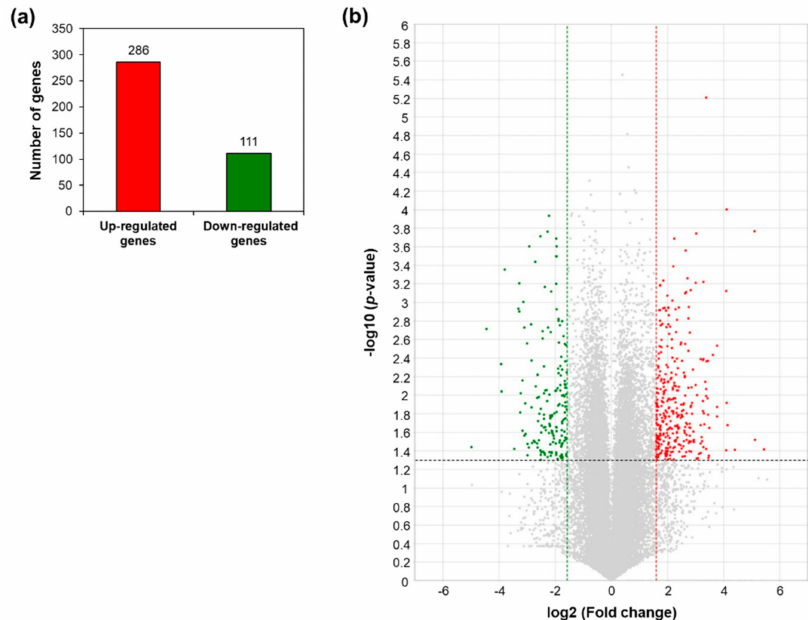
Figure 1. Di ff erentially expressed genes in AtRH17 -overexpressing transgenic plants (OXs) compared to wild type (WT) from the RNA-Sequencing (RNA-Seq) analysis. ( a ) Numbers of genes more than 3-fold up- and downregulated in AtRH17 OXs compared to WT. ( b ) Volcano plot of di ff erentially expressed genes (DEGs) identified between WT and AtRH17 OXs ( p -value < 0.05 and log2 ratio ≥ 1). The upregulated genes are represented by a red dot and downregulated genes by a green dot, grey dots indicate genes that are not di ff erentially